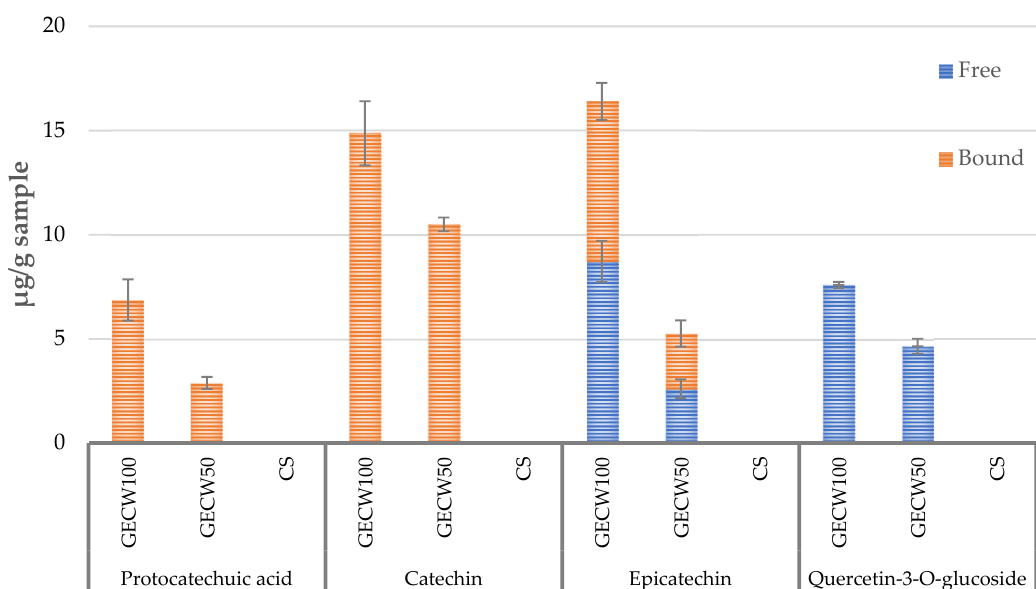
Figure 3. Bound and free (poly)phenol compounds identified in cooked beef burger elaborated with cocoa bean shell flour and walnut oil emulsion gel as partial and total pork backfat replacers. CS: control sample elaborated with the traditional formula; GECW50: sample with 50% gelled emulsion elaborated with cocoa bean shell flour and walnut oil as fat replacer; GECW100: sample with 100% gelled emulsion elaborated with cocoa bean shell flour and walnut oil as fat replacer.